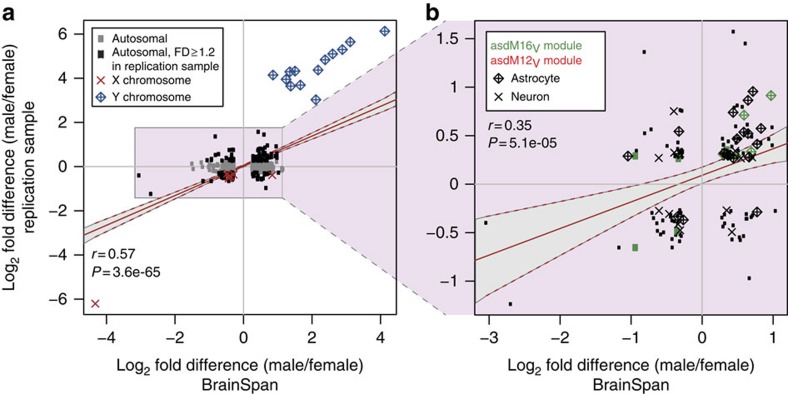
Male-biased expression of astrocyte and asdM16V module genes in an independent sample.(a) FD for all sex-DE genes from the BrainSpan sample also tested in the replication set (BrainSpan FD≥1.2, P<0.05, 733 genes; grey points mark genes with FD<1.2 in the replication sample), and for (b) autosomal sex-DE genes from BrainSpan with FD≥1.2 in the replication sample (129 genes). Best-fit lines and 95% confidence intervals are shown on plots.